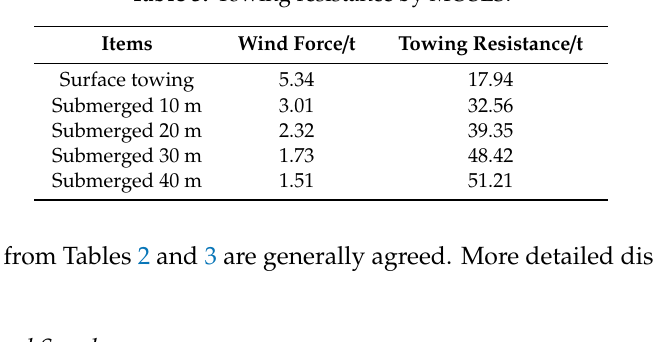
Table 3. Towing resistance by